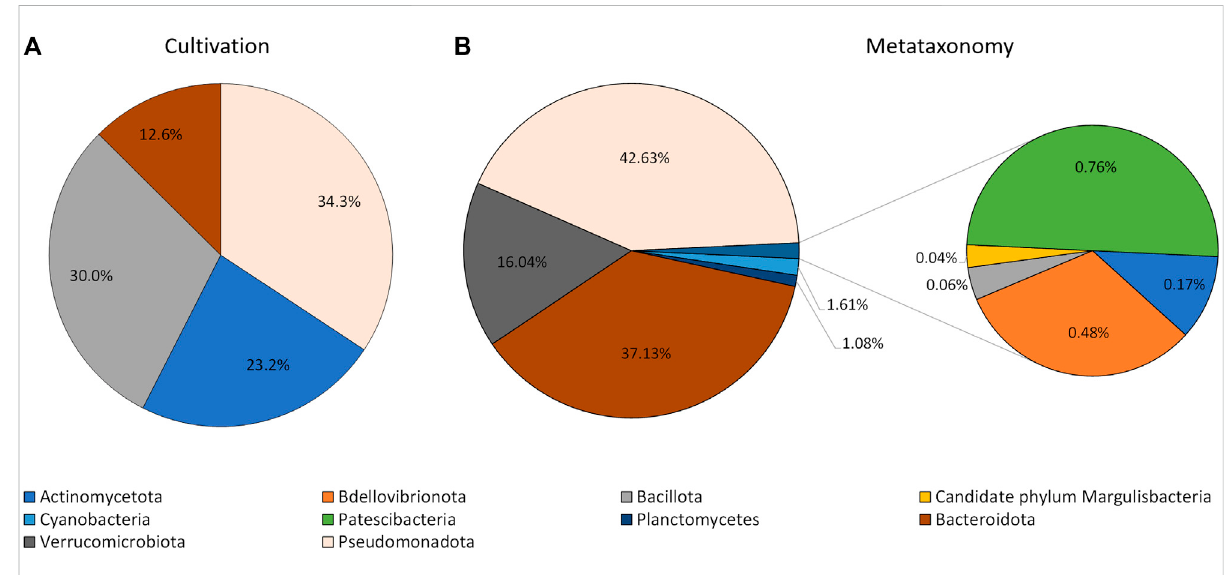
FIGURE 3 Phyla of bacteria identi fi ed using cultivation methods and the lipid pro fi le (A) , and metataxonomy (B)